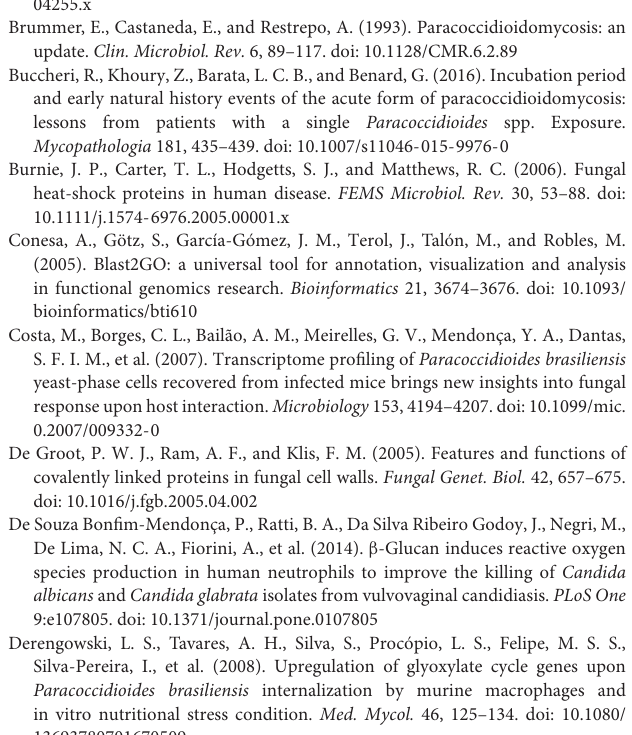
FIGURE S1 | Schematic overview of performed experiments. Nine cultures were prepared with P. brasiliensis , grown as mycelium, mycelium-to-yeast, and yeast cells. After 72 h of growth for mycelium and yeast and 22 h for transition, the cultures were collected and the proteins extracted and digested in peptides. The three-condition samples (mycelium, transition, and yeast) from each replicate were labeled with iTRAQ (114, 116, and 115 tag). FIGURE S2 | Flowchart of the filters applied to the identified proteins during mycelium, mycelium-to-yeast transition, and yeast cells. It was considered those proteins with high or medium FDR confidence and those that were found in at least two replicates. FIGURE S3 | Proteins identified in P. brasiliensis that were annotated by Blast2GO. (A) Number of sequences analyzed and that had annotation. (B) Top-hit of species that were homologous to proteins found using Blast2GO. FIGURE S4 | Schematic diagram of the metabolic processes in cell wall differentially expressed in mycelia and yeast cells. The figure summarizes the data obtained from proteomic analysis; enzymes are listed as follows: CTS2, chitinase; ECM33; β -1,3-exoglucanase; 1,3- β -glucosidase; β -1,6 glucan synthase (Knh1); M, mycelium; T, transition from mycelium to yeast cells; Y, yeast cells. FIGURE S5 | Mitochondrial activity assay in mycelia, transition mycelia-to-yeast, and yeast cells. The images were acquired to mycelia, transition mycelia-to-yeast, and yeast cells (magnification 400 × ) in the Microscope Axio Scope A1 (Zeiss), using the AxioVision Software (Carl